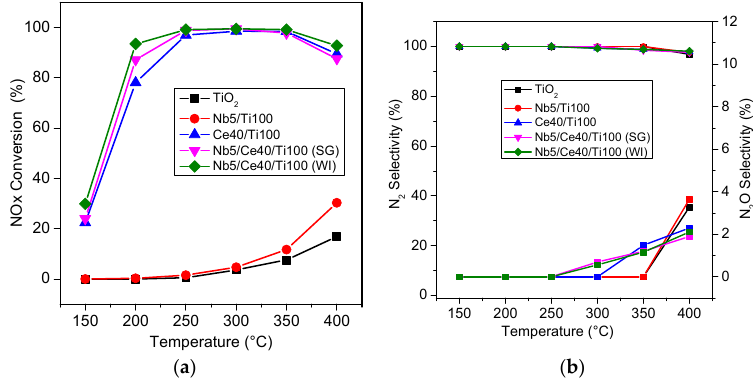
Figure 1. ( a ) NO x conversion and ( b ) N 2 -N 2 O selectivity for different catalysts (1000 ppm NO x , 1000 ppm NH 3 , 5% O 2 /He, GHSV = 60,000 mL·g − 1 ·h − 1 ).